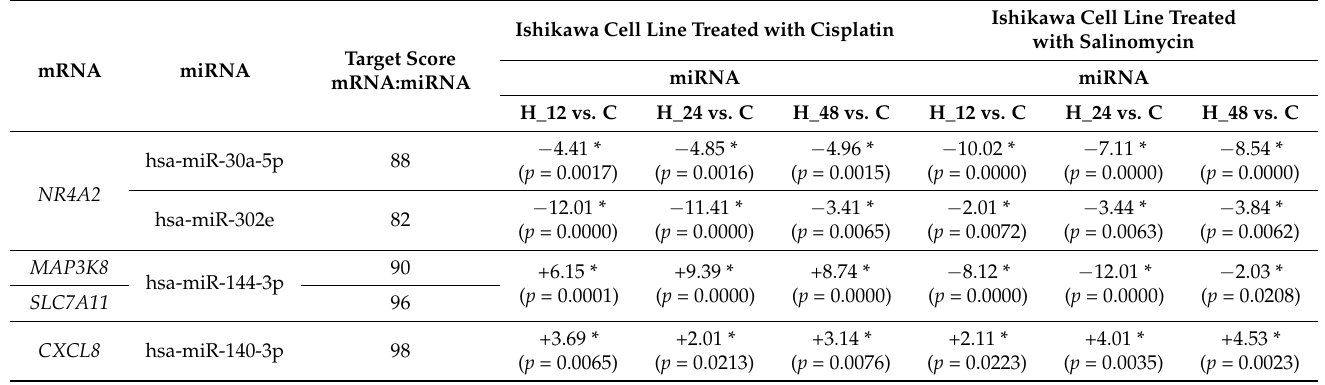
Table 4. Expression profiles of miR-30a-5p, miR-302e, miR-144-3p, and miR-140-3p in an endometrial cancer cell line exposed to cisplatin or salinomycin, compared to the control.